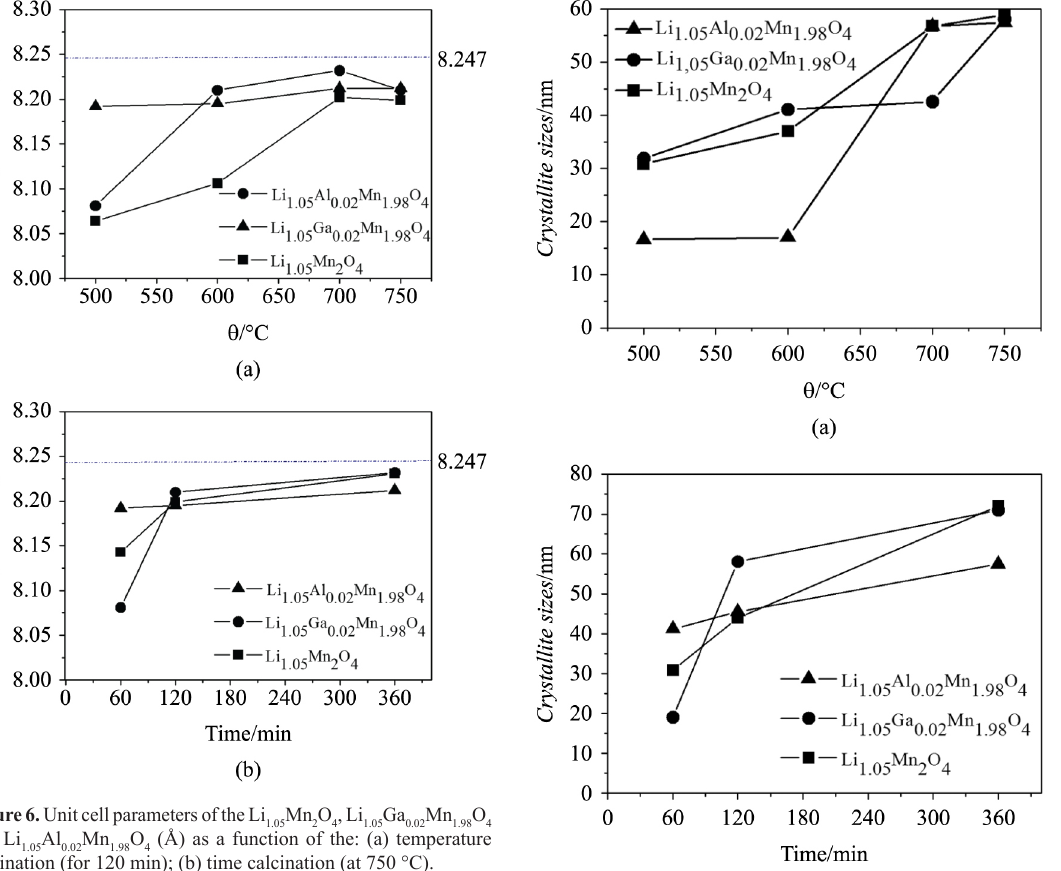
Mn O , Li Ga Mn O and 1.05 2 4 1.05 0.02 1.98 4